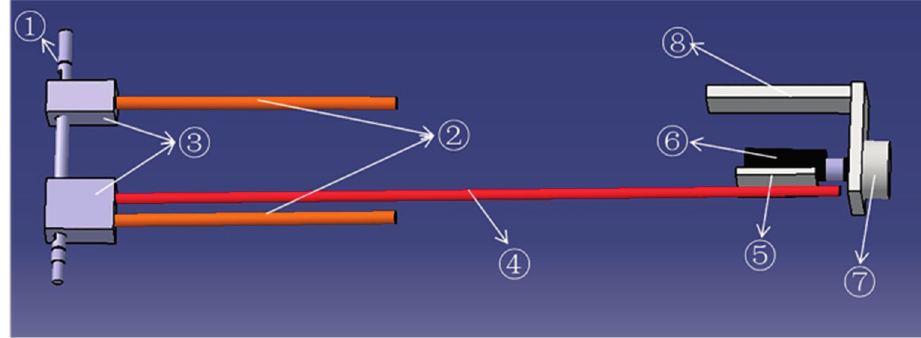
Figure 5. The force-sensing mechanism. ( ① a steel shaft connects to the motor shaft; ② two steel bars act as the elastic element; ③ connectors; ④ long steel bar; ⑤ a rubber sheet connected to the long steel bar; ⑥ connector; ⑦ angle sensor; ⑧